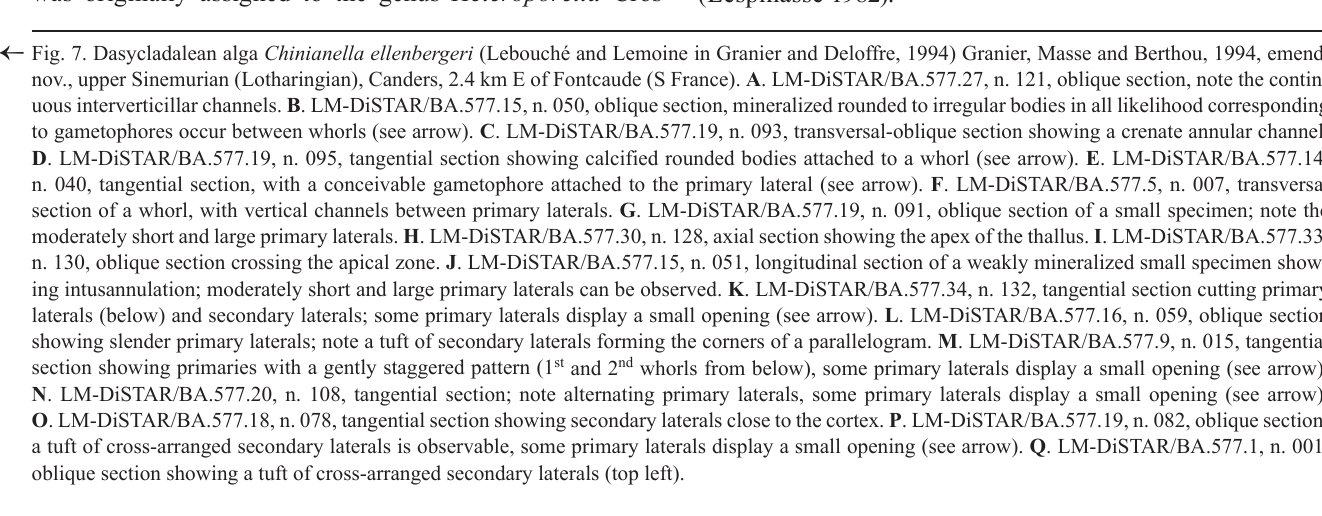
Fig. 7. Dasycladalean alga Chinianella ellenbergeri (Lebouché and Lemoine in Granier and Deloffre, 1994) Granier, Masse and Berthou, 1994, emend. nov., upper Sinemurian (Lotharingian), Canders, 2.4 km E of Fontcaude (S France). A . LM-DiSTAR/BA.577.27, n. 121, oblique section, note the contin- uous interverticillar channels. B . LM-DiSTAR/BA.577.15, n. 050, oblique section, mineralized rounded to irregular bodies in all likelihood corresponding to gametophores occur between whorls (see arrow). C . LM-DiSTAR/BA.577.19, n. 093, transversal-oblique section showing a crenate annular channel. D . LM-DiSTAR/BA.577.19, n. 095, tangential section showing calcified rounded bodies attached to a whorl (see arrow). E . LM-DiSTAR/BA.577.14, n. 040, tangential section, with a conceivable gametophore attached to the primary lateral (see arrow). F . LM-DiSTAR/BA.577.5, n. 007, transversal section of a whorl, with vertical channels between primary laterals. G . LM-DiSTAR/BA.577.19, n. 091, oblique section of a small specimen; note the moderately short and large primary laterals. H . LM-DiSTAR/BA.577.30, n. 128, axial section showing the apex of the thallus. I . LM-DiSTAR/BA.577.33, n. 130, oblique section crossing the apical zone. J . LM-DiSTAR/BA.577.15, n. 051, longitudinal section of a weakly mineralized small specimen show- ing intusannulation; moderately short and large primary laterals can be observed. K . LM-DiSTAR/BA.577.34, n. 132, tangential section cutting primary laterals (below) and secondary laterals; some primary laterals display a small opening (see arrow). L . LM-DiSTAR/BA.577.16, n. 059, oblique section showing slender primary laterals; note a tuft of secondary laterals forming the corners of a parallelogram. M . LM-DiSTAR/BA.577.9, n. 015, tangential section showing primaries with a gently staggered pattern (1 st and 2 nd whorls from below), some primary laterals display a small opening (see arrow). N . LM-DiSTAR/BA.577.20, n. 108, tangential section; note alternating primary laterals, some primary laterals display a small opening (see arrow). O . LM-DiSTAR/BA.577.18, n. 078, tangential section showing secondary laterals close to the cortex. P . LM-DiSTAR/BA.577.19, n. 082, oblique section; a tuft of cross-arranged secondary laterals is observable, some primary laterals display a small opening (see arrow). Q . LM-DiSTAR/BA.577.1, n. 001, oblique section showing a tuft of cross-arranged secondary laterals (top left).